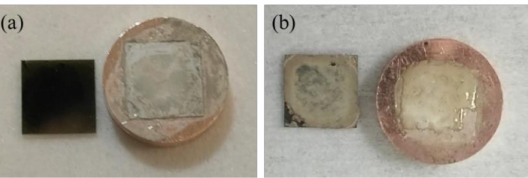
Figure 11. The photographs of different pastes after shear strength test. ( a ) Ag 2 O paste and ( b ) Ag agglomerates